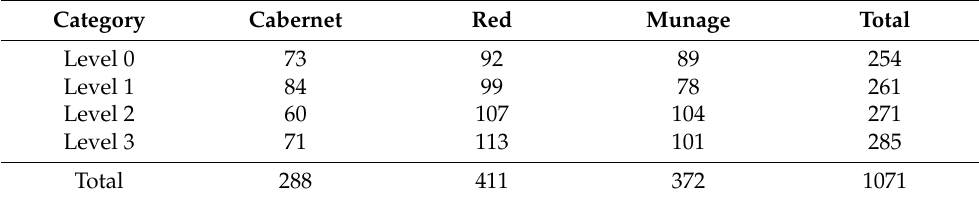
Figure 1. The flow chart of spraying pesticides and obtaining clusters of the grape. Table 1. Number of samples after cutting intact Table 1. Number of samples after cutting intact grapes.